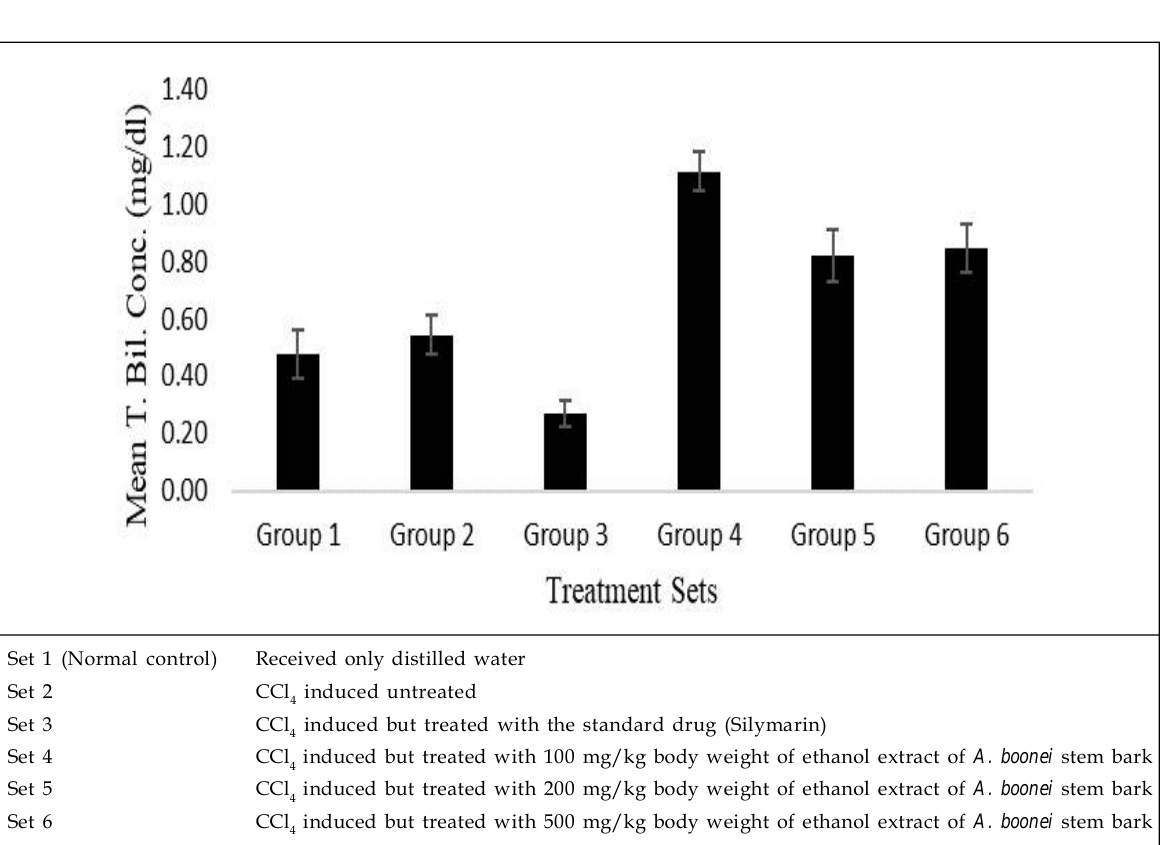
Figure 4: TBil concentration of male Wistar albino rats administered A. boonei stem bark extract